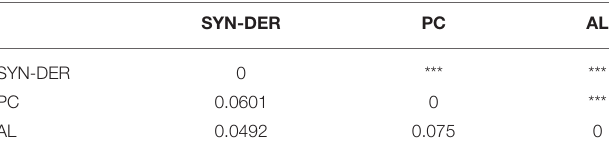
SYN-DER, synthetic-derived wheats; PC, commercially released Pakistan cultivars; AL, advanced breeding lines. *** Represents significant differences between two populations